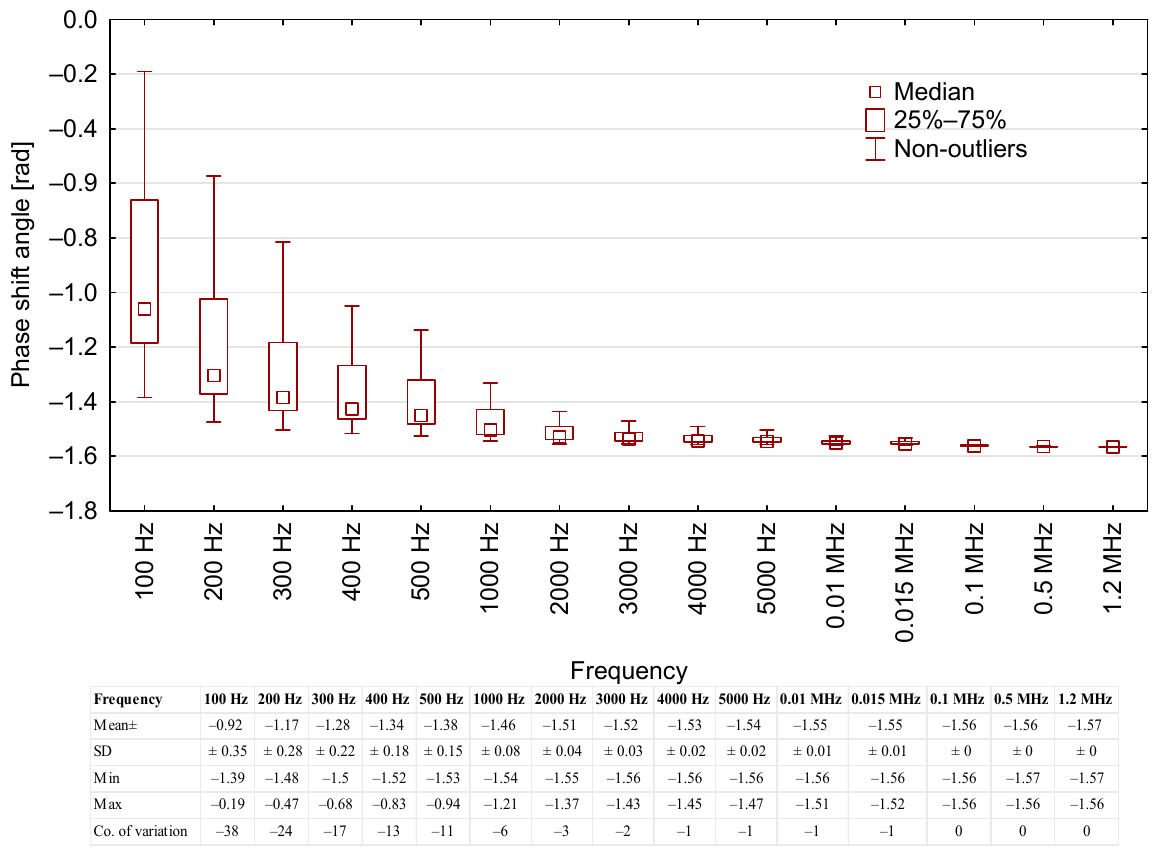
Figure 3. Correlation between phase shift angle readings for the tested oil samples and the test voltage frequency, including base data for the results.